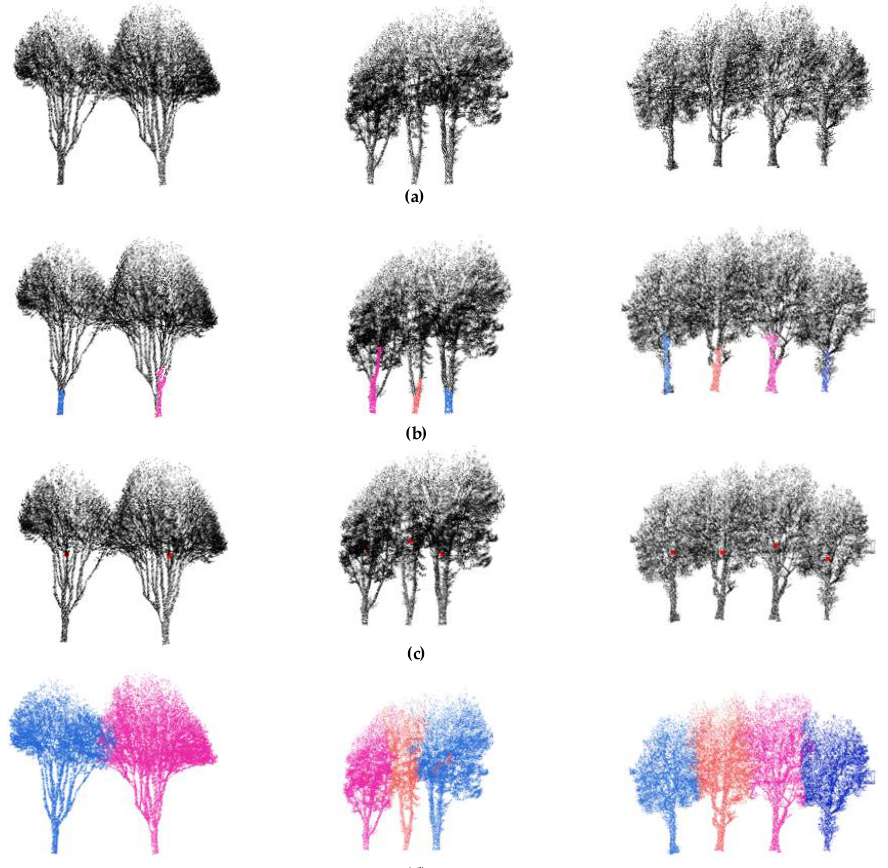
Figure 10. Individual tree extraction process of Scene 1, Scene 2 and Scene 3. ( a ) The PCD of trees. ( b ) Trunk extraction results. ( c ) Crown center extraction results. ( d ) Individual tree extraction re- sults.